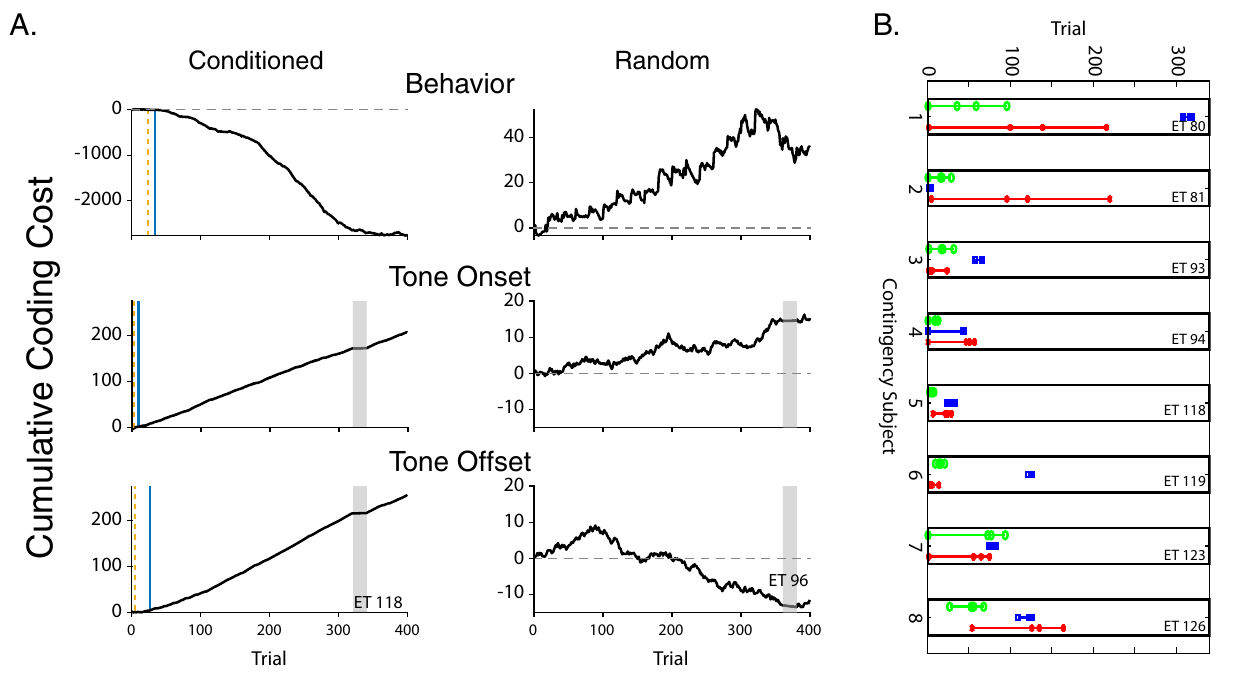
Fig. 5 Dopamine re fl ects reward availability before behavioral conditioning. A Cumulative coding costs as a function of trial number are presented for one subject in the conditioned group (Left column) and one subject in the random group (Right column). Cumulative coding costs are depicted for behavior (Tone/ITI lever press ratio) in the top row, DA release (dLight) at Tone Onset in the middle row and DA release at Tone Offset in the bottom row. Note the differences in Y axes scales for the conditioned and random subject. Gray shaded region indicates missing recording session. Vertical dashed line indicates when differences began, vertical solid line indicates signi fi cance at α = 0.01. B The trial number at which 4 events are detected for each variable for each subject in the conditioned group: the beginning of the accumulation of evidence for a difference in the value (in the predicted/ terminal direction) and, 3 levels of signi fi cance: odds of 10:1 ( α = 0.1), 20:1 ( α = 0.05), and 100:1 ( α = 0.01). Green = DA at S − onset, Red = DA at S − offset, Blue =